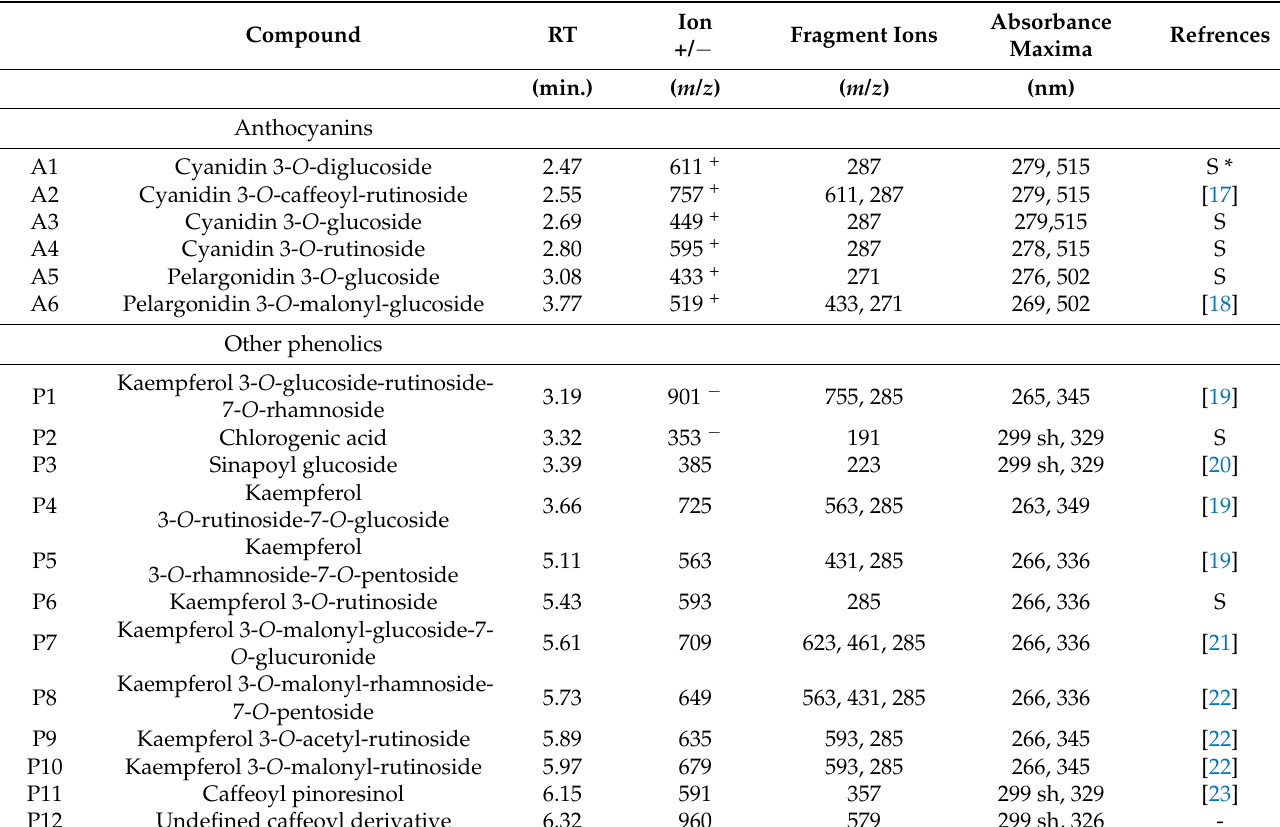
Table 2. Phenolics